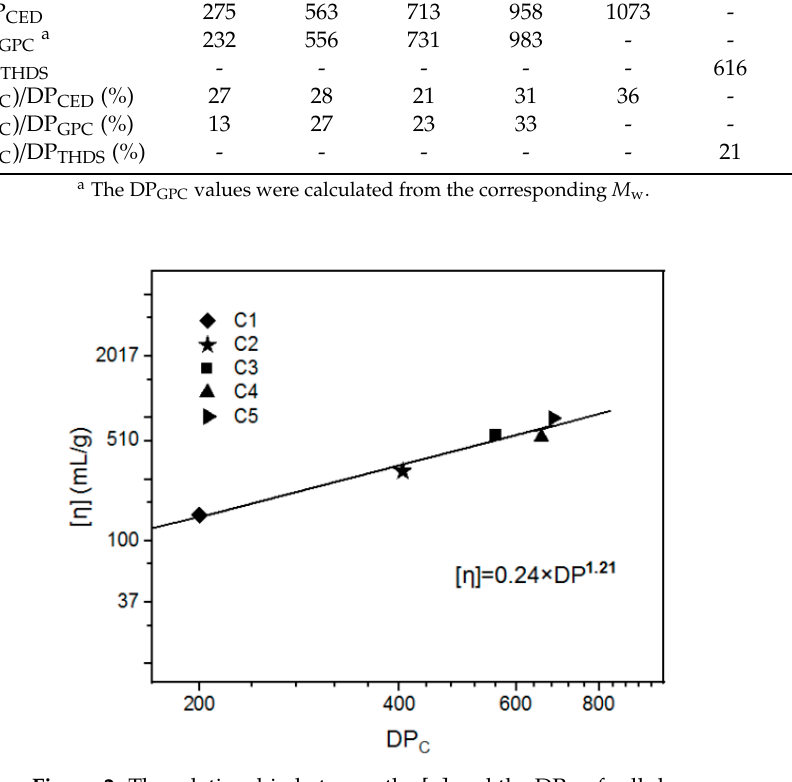
Table 4. The DP values of cellulose samples C1–C7 determined by different methods.